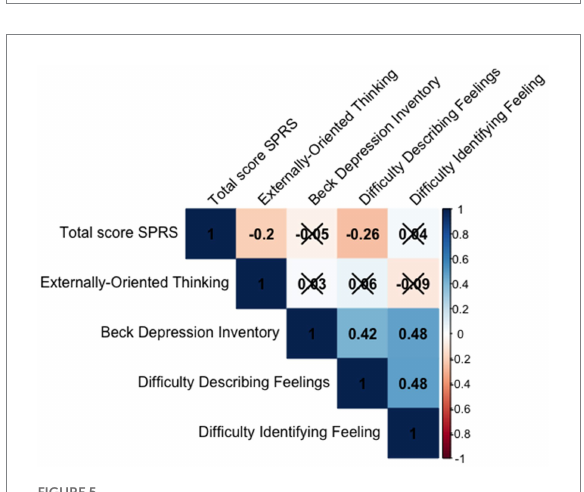
FIGURE 5 Correlation indicating SSC convergent and divergent validity. Non-significant correlations are marked with an X.